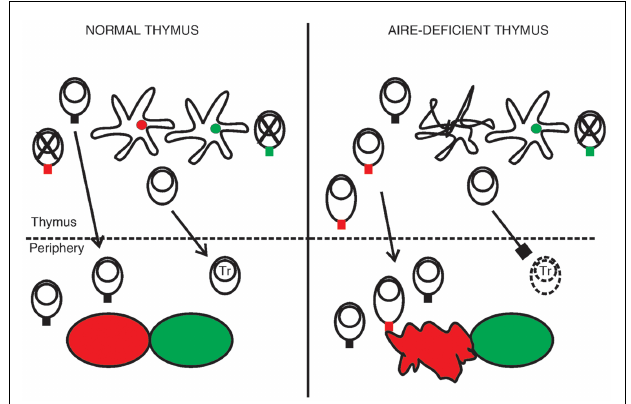
FIGURE 2 |A hypothesis of the pathogenesis ofAPECED . In the normal thymus mTECs express a range of tissue-restricted antigens, shown here as red and green circles within the mTECs.This facilitates the deletion of autoreactive thymocytes, shown as cells with a red or greenTCR, so that onlyT cells reactive to non-self antigens migrate to the periphery.The normal thymus also supports the development of regulatoryT cells (Tr). In the absence of functional AIRE the epithelial compartment is disrupted, as indicated by the malformed mTEC, and some of theTRAs are no longer transcribed.Thymocytes specific to theseTRAs mature in increased numbers.They may also become activated already in the thymus, shown here as an increase in cytoplasm volume, so that the thymus exports functional effector cells. At the same time the development ofTr cells is defective, leading to insufficient suppression in the periphery.The outcome is organ-specific autoimmunity, at least partly directed by the range ofTRAs missing in the AIRE-deficient thymus (here indicated by the red